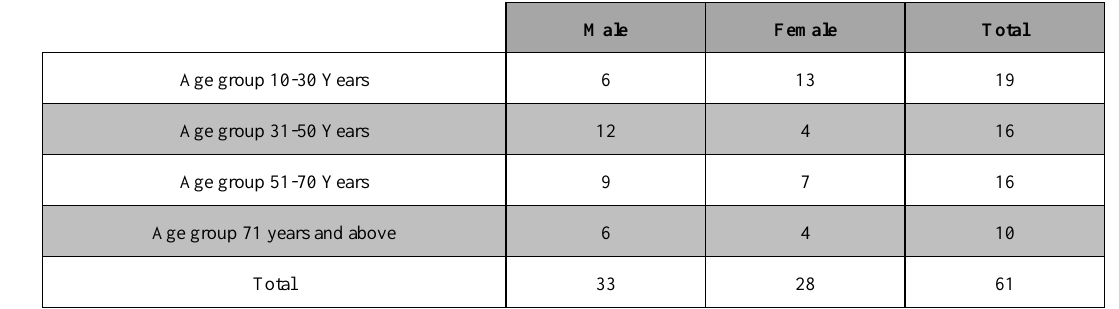
Table 3. Age and sex distribution of study population.